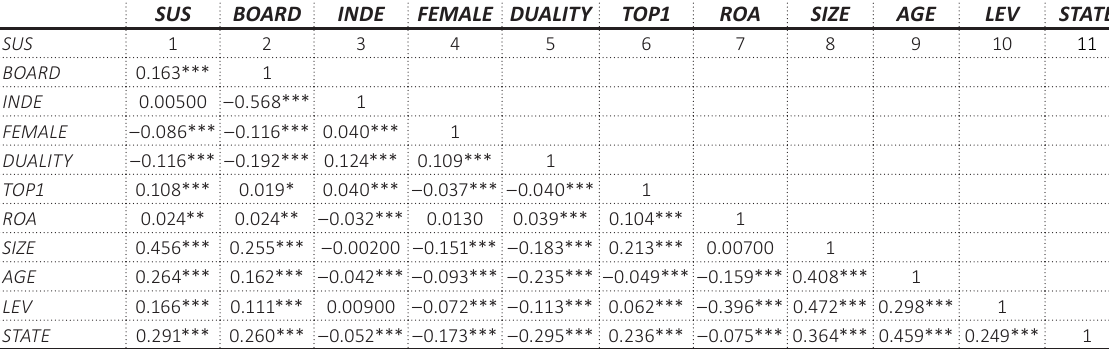
Table 5. Correlations matrix